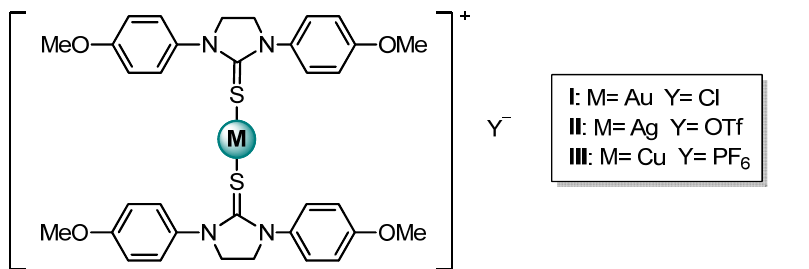
Figure 2. Thiourea-group 11 metal complexes I-III with good cytotoxic activity.